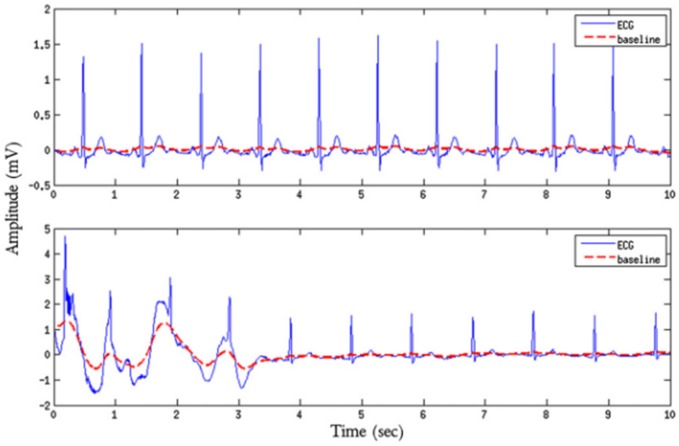
ECG quality comparison chart with or without baseline shift.